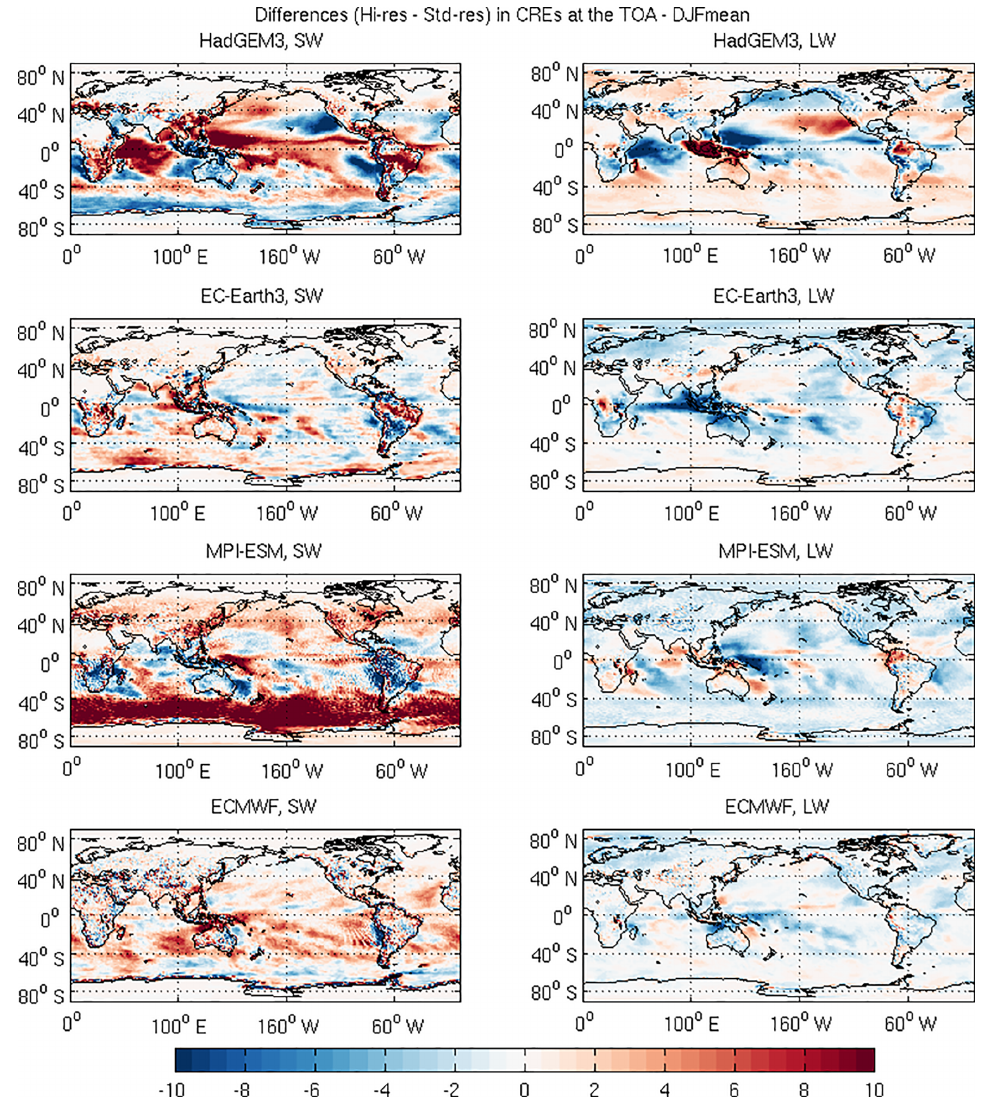
Figure 2. Differences in the CREs at the TOA during DJF (Wm − 2 ) between the Hi-res and Std-res configurations of the respective models in the SW (left) and LW